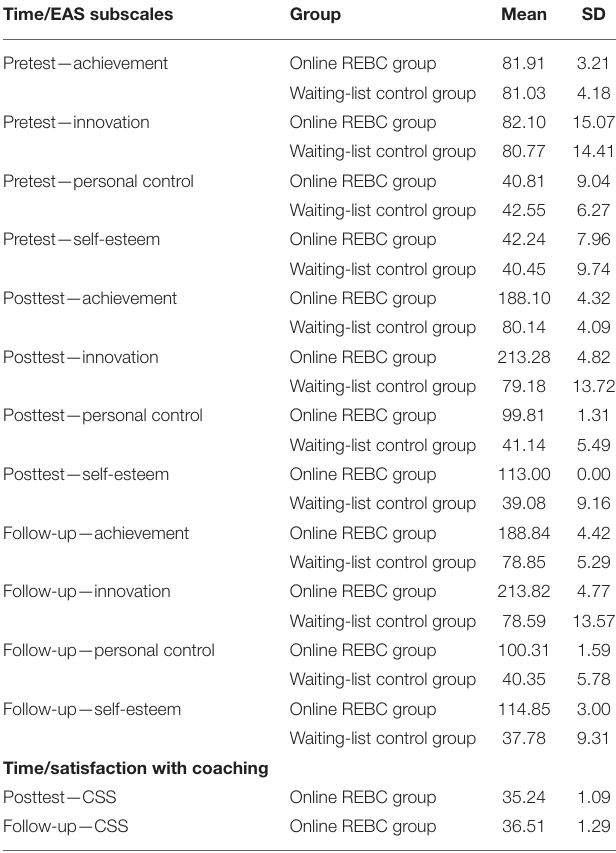
TABLE 2 | Descriptive statistics (means and standard deviations) for the study variables by time and study group. Time/EAS